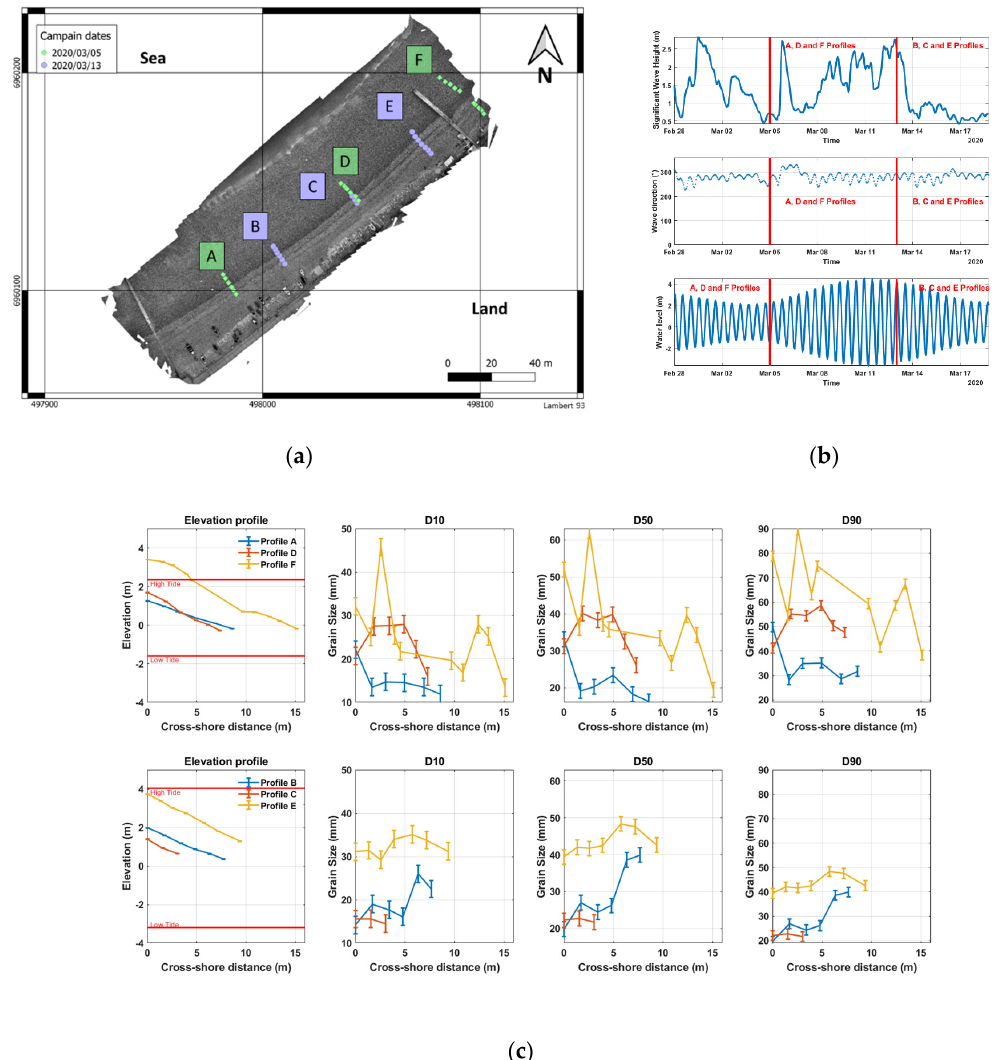
Figure 6. ( a ) Location of the cross-shore quadra measurement profiles at Etretat on 5 March and 13 March, 2020. ( b ) Hydrodynamic conditions during the measurements: significant wave height (top), wave direction (center) and water level (bottom). ( c ) Elevation and pebble size profiles of D10, D50 and D90 on 5 March, 2020 (top) and 13 March, 2020 (bottom). Vertical bars show the measurement uncertainty, and horizontal red lines show the intertidal extension of the last tide. Table 1. Mann–Kendall statistical test applied to the pebble size profiles measured in Etretat on 5 March and 13 March, 2020, P-Values in bold are inferior to the 0.1 significance threshold.